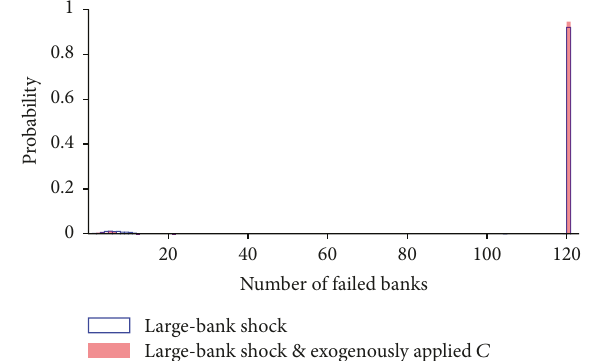
Figure 14: A comparison of probability distributions of number of failed banks after a large-bank shock in the LI1 scenario, and scenario in which con fi dence from the LI1 scenario was exogenously applied to the CI scenario. The probability of systemic breakdown is nearly the same in both scenarios. CI is a scenario in which a bank has access to information from all other banks in the network. LI1 is a scenario in which a bank has access only to information from its direct neighbors at distance